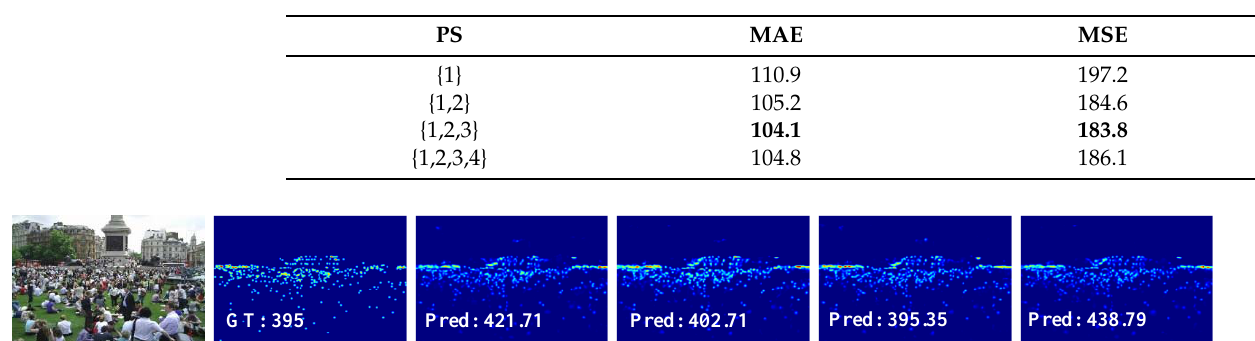
Table 4. Comparisons of our proposed method with different pyramid scale settings (PS) on the UCF- QNRF dataset. The value of PS is the dilated rate of each dilation convolution branch from MSCA.